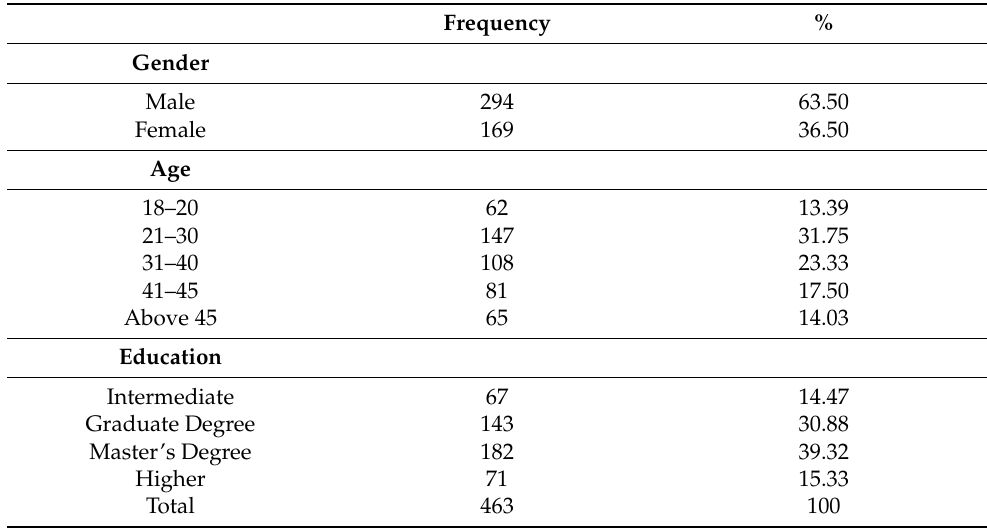
Table 1. Demographic